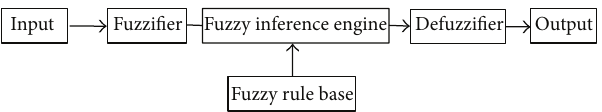
Figure 1: Schematic diagram of Mamdani fuzzy logic